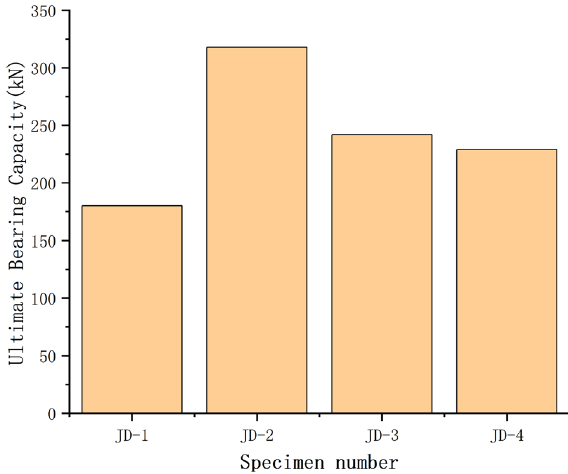
Figure 7. Ultimate bearing capacity of